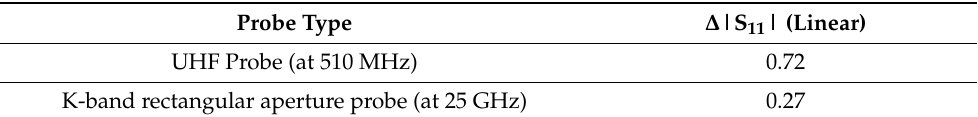
Figure 5. Picture of the simulation setup to assess probe sensitivity for damaged patch antenna. Table 1. Change in magnitude of reflection coefficient of imaging